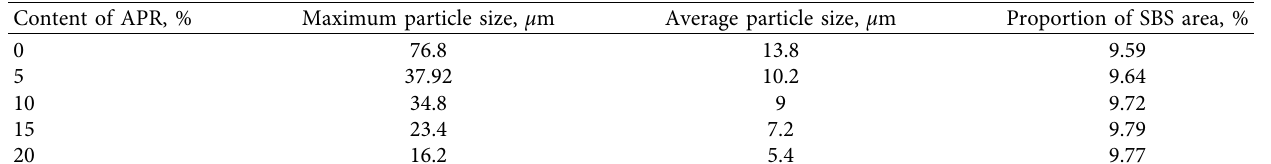
Figure 13: Fluorescence microscopic binarization image of SBS modified asphalt with 20% content of APR. Table 5: Maximum particle size and average particle size of SBS.